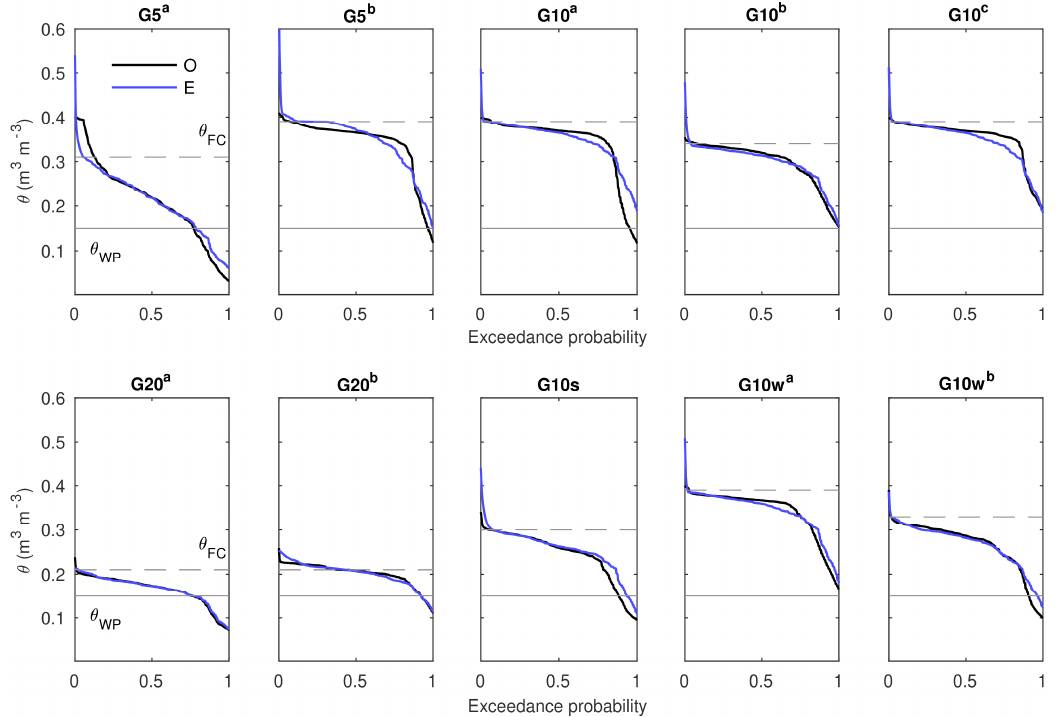
Figure 5. Observed (O) (black lines) and estimated (E) (blue lines) soil water content duration curve for each specimen during the rainy season 2014.